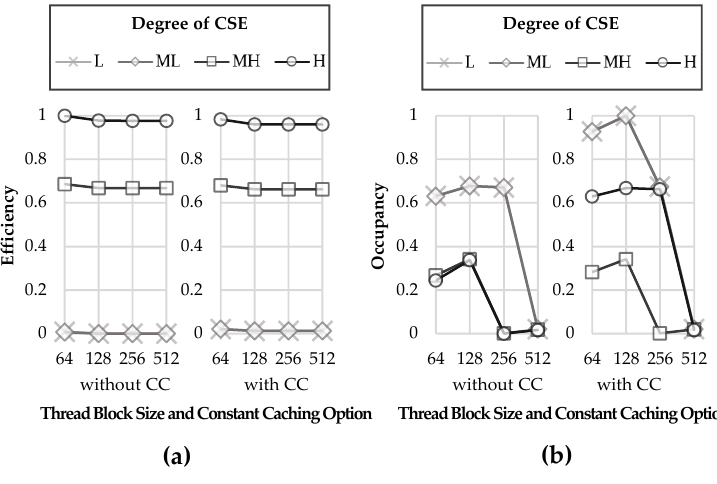
Figure 7. Performance metrics of configurations. ( a ) Efficiency; ( b ) Occupancy.